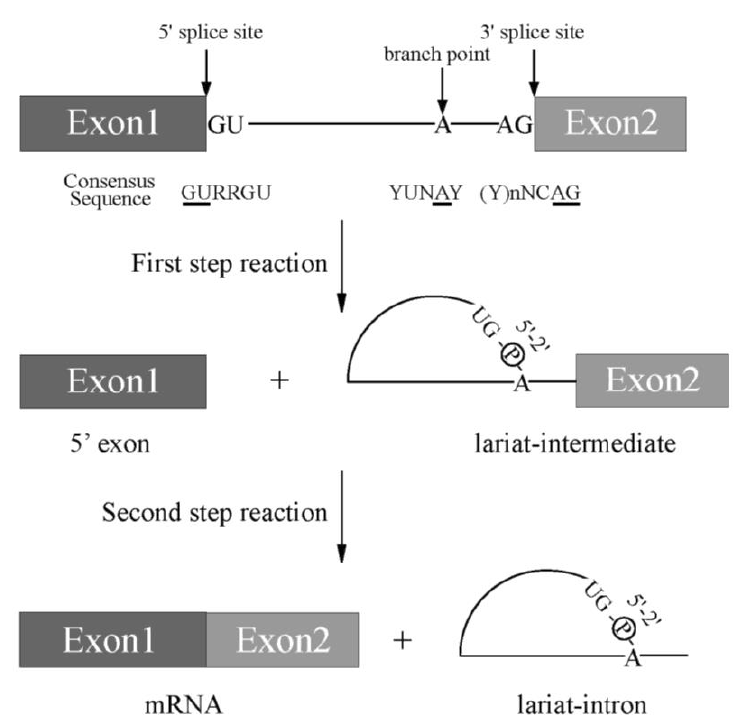
Figure 1. A scheme for splicing reaction with two steps. Schematic representation of sequences re- quired for splicing reaction. Boxes show exons, and lines between boxes represent introns. Conserved sequence elements of metazoan pre-mRNAs. R and Y stand for purine and pyrimidine residues, respectively. N indicates any nucleotides. Conserved 5′ and 3′ splice sites, and Adenosine residue used for branch nucleotide are underlined.